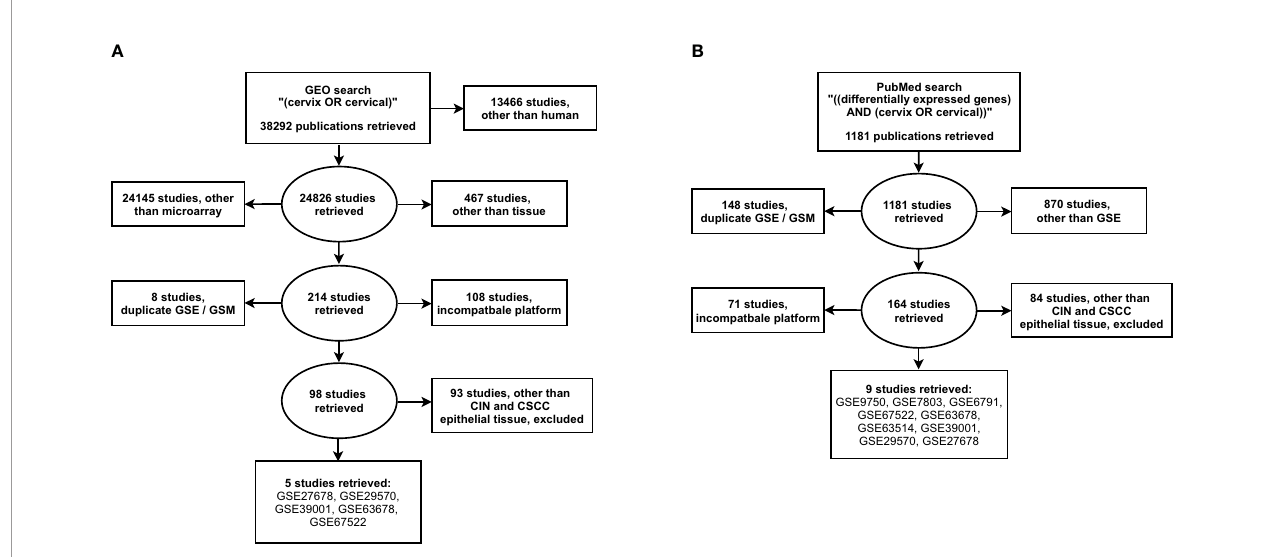
FIGURE 1 | Search strategy for the selection of eligible gene expression studies from the (A) NCBI GEO and the (B) NLM PubMed. GSE, gene expression series; GSM, gene expression sample. NCBI, National Center for Biotechnology Information; GEO, Gene Expression Omnibus; NLM, National Library of Medicine.